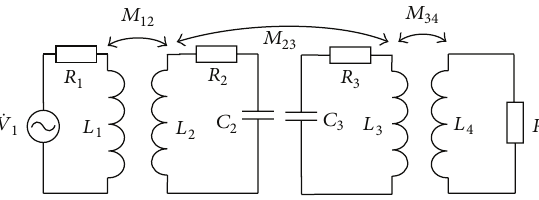
Figure 1: Equivalent circuit model of a resonant system.